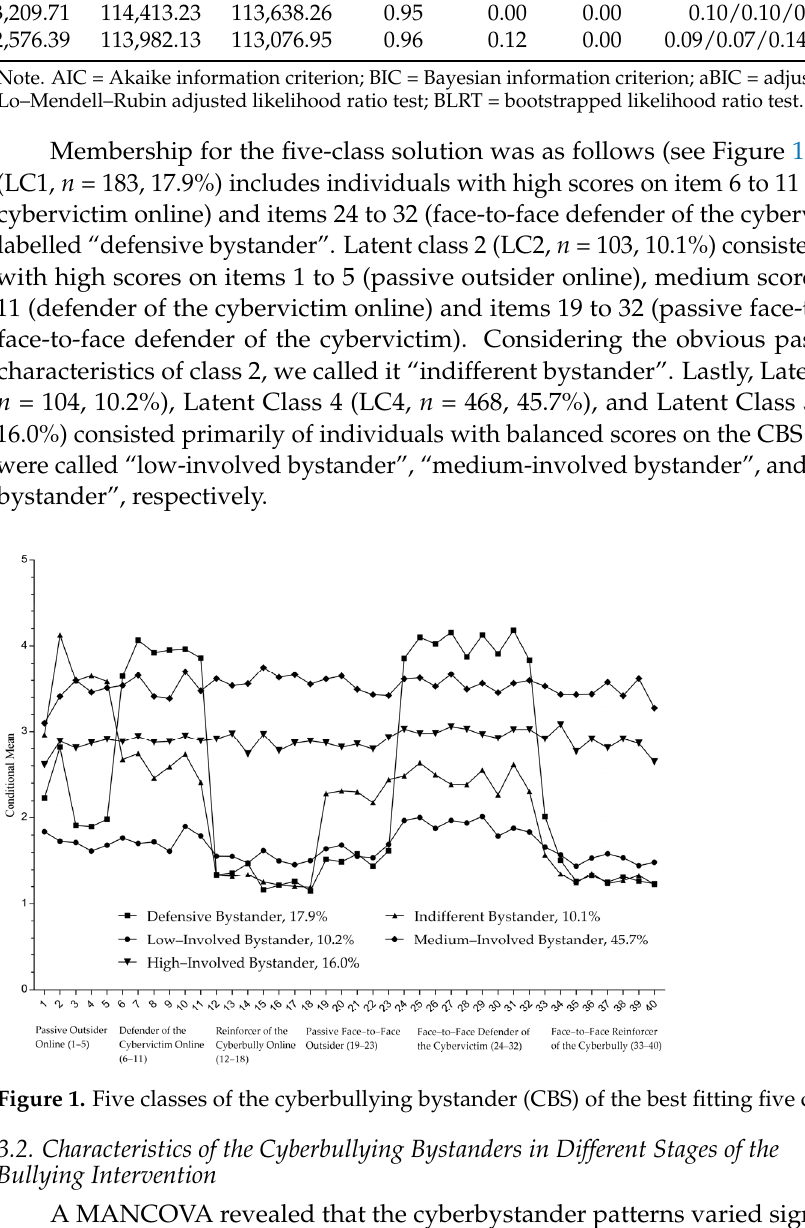
Table 1. Fit indices for the latent class models on the cyberbullying bystander for the total sample.